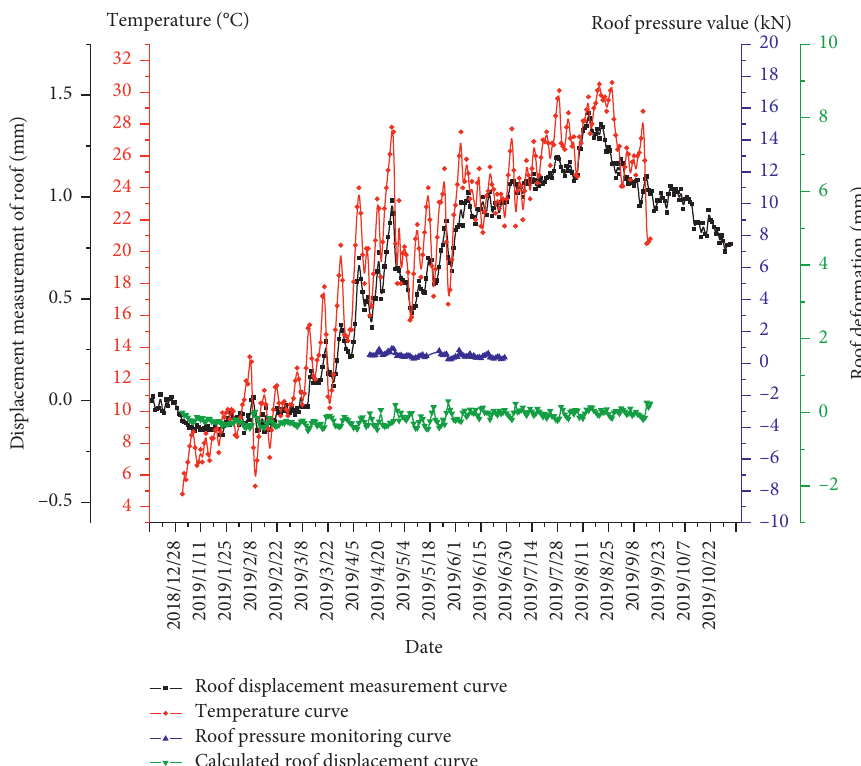
Figure 12: Curve comparisons after temperature drift correction.